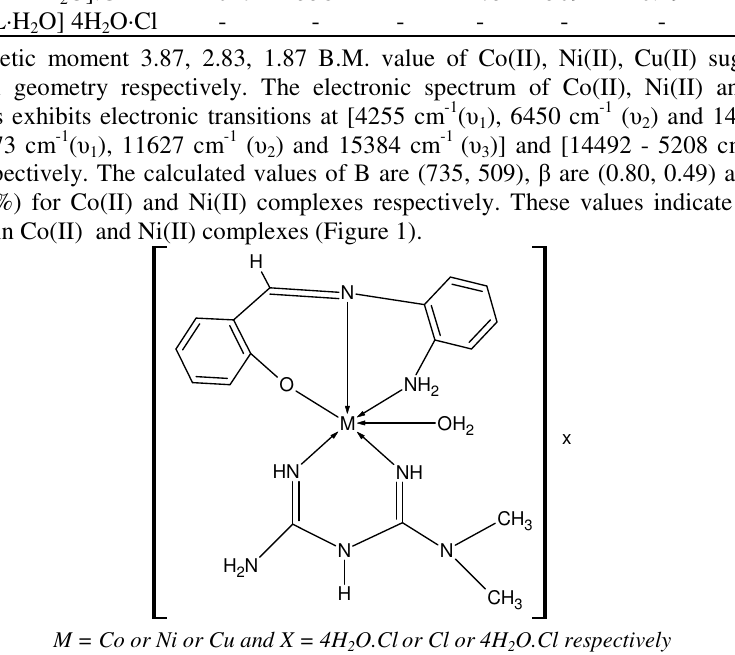
Table 6. Parameters of the electronic spectra of metal complexes d-d transition, cm -1 Complex